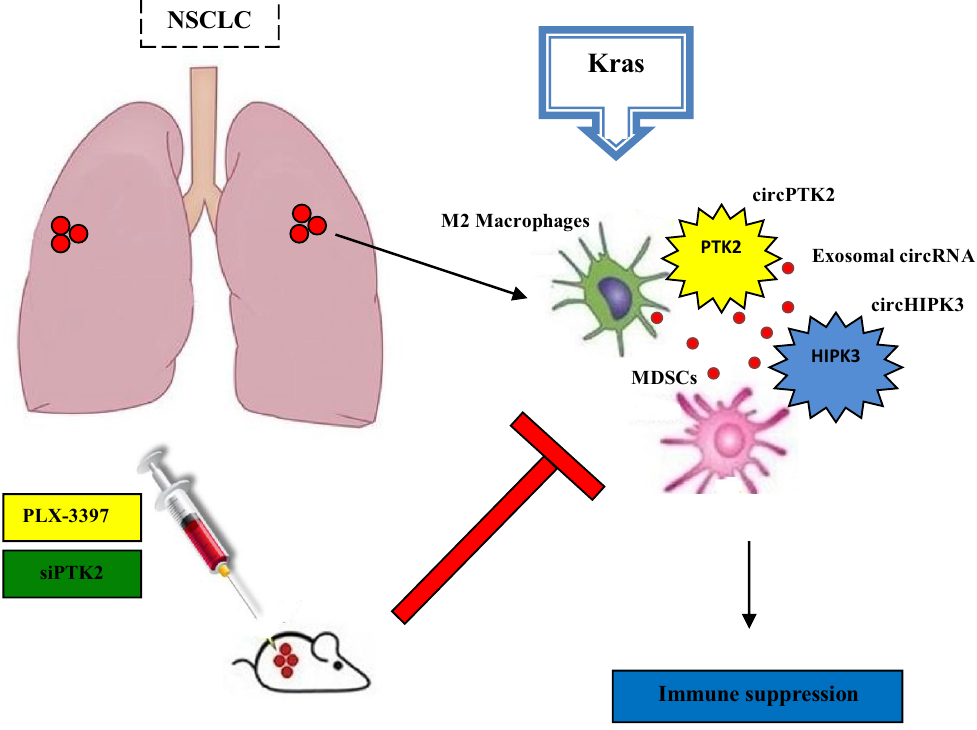
Figure 7. The molecular mechanism of Kras-induced immunosuppression via infiltration of intra-epithelial CD163 + /CD206 + M2 macrophages and circHIPK3/PTK2